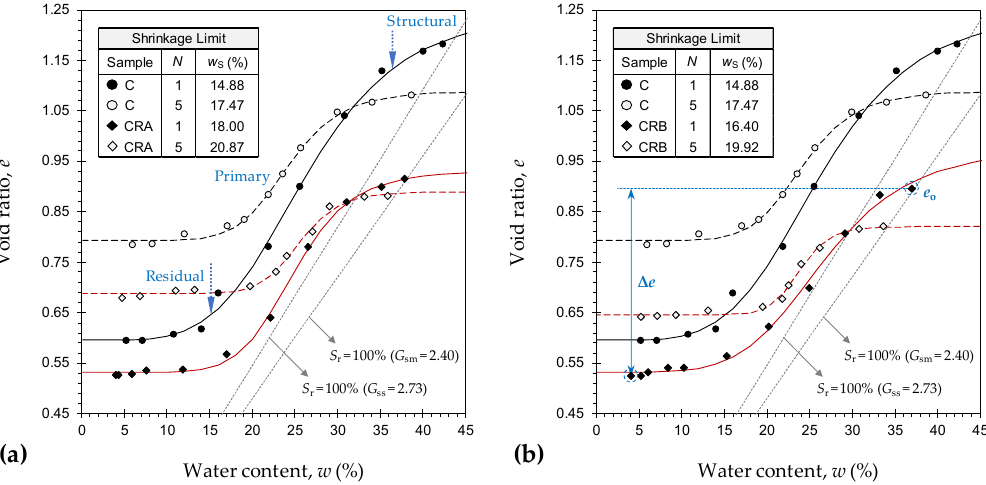
Figure 7. Void ratio–water content shrinkage curves, at N = 1 and 5, for the tested samples: ( a ) C and CRA; and ( b ) C and CRB.